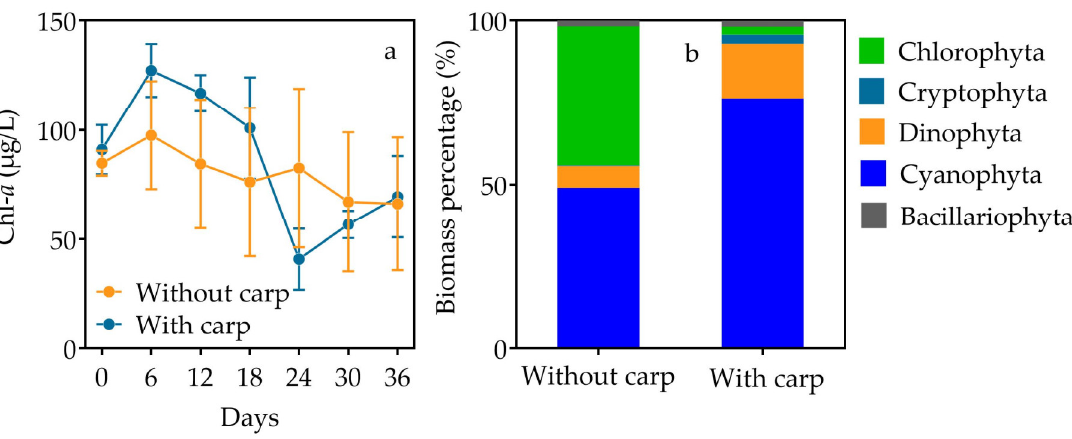
Figure 3. Comparisons of ( a ) Chl-a concentration during the experimental period and ( b ) biomass percentage of phytoplankton phyla between the two treatments. Values denote mean ± SE ( n = 3).